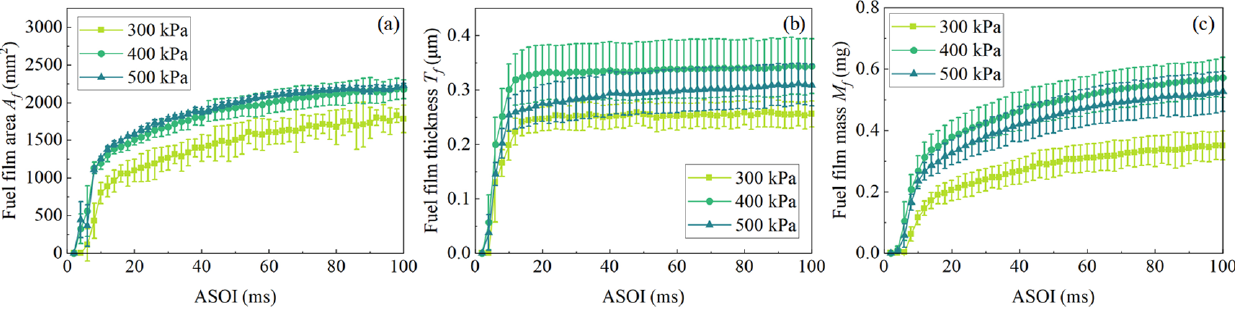
Figure 18. ( a ) Fuel film area f A , ( b ) Fuel film thickness f T and ( c ) Fuel film mass f M on the wall under different inj P (300 kPa to 500